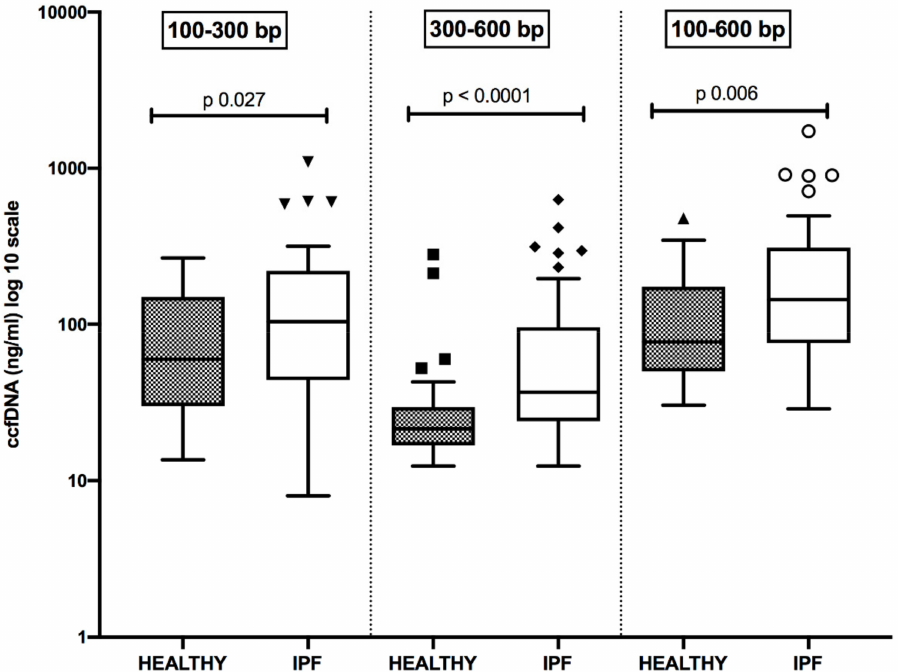
Figure 1. Distribution of plasma concentrations (log 10 scale) of small size circulating cell-free DNA (ccfDNA) in healthy subjects and patients suffering from idiopathic pulmonary fibrosis (IPF). All comparisons are statistically